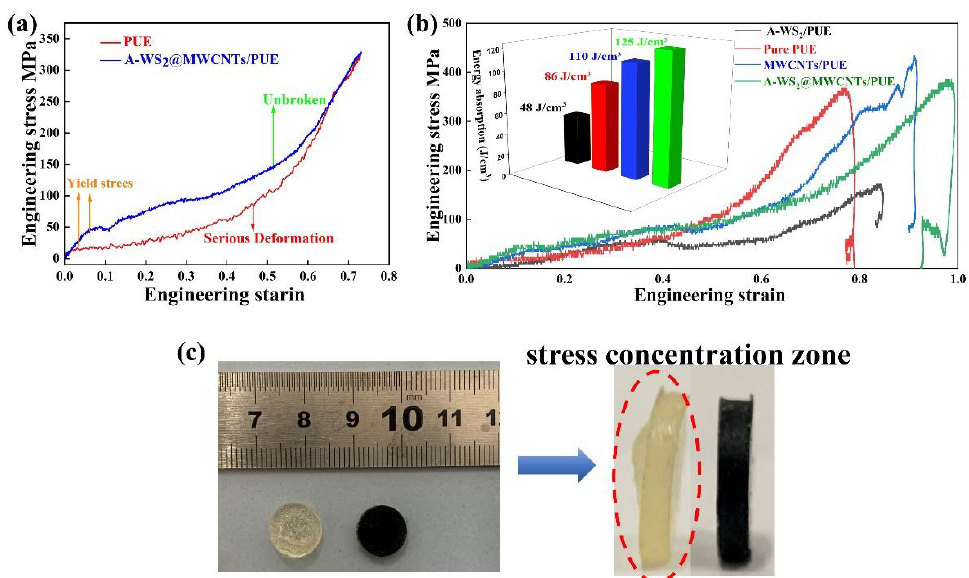
Figure 5. ( a ) Stress-strain curve of PUE and 1.5%A-WS 2 @MWCNTs/PUE under 0.2 MPa impact load, ( b ) stress-strain curve and energy absorption value of 1.5%A-WS 2 /PUE,1.5% MWCNTs/PUE, and 1.5%A-WS 2 @MWCNTs/PUE under the 0.2 MPa impact load, and ( c ) deformation of pure PUE and 1.5%A-WS 2 @MWCNTs/PUE under 0.2 MPa impact